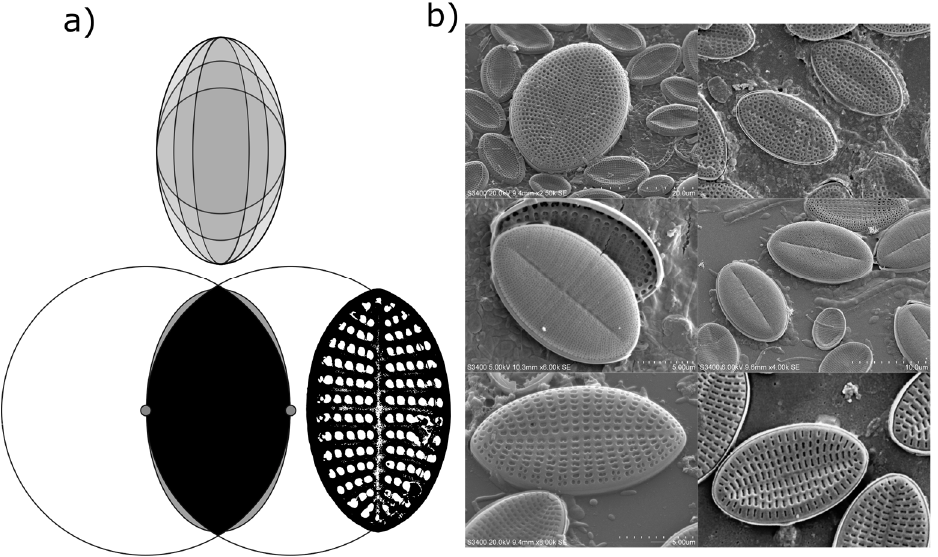
Figure 3. Examples of aspect ratios that a given ellipse might take (( a ), top) when fitted to a frustule. The shape of many examined frustules was between that of an ellipse and a vesica piscis (( a ), bottom), while ( b ) illustrates the variety of shapes encountered in surface-attached diatom frustules observed in the present study.